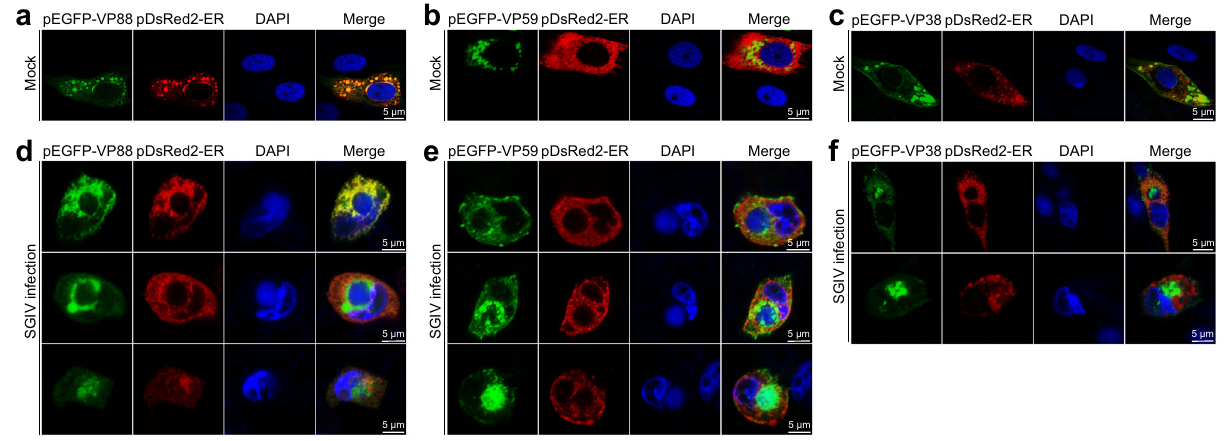
Fig.5|ERlocalizationoftheanchorprotein. LocalizationofVP88( a ),VP59( b ),or VP38 ( c ) with DsRed2-ER (an ER marker) after cotransfection with the plasmid (pEGFP-VP88,pEGFP-VP59,orpEGFP-VP38)expressingonemCPfusedtoEGFPand pDsRed2-ERplasmidintoEAGScells.MultiplelocalizationstatesbetweenVP88( d ),